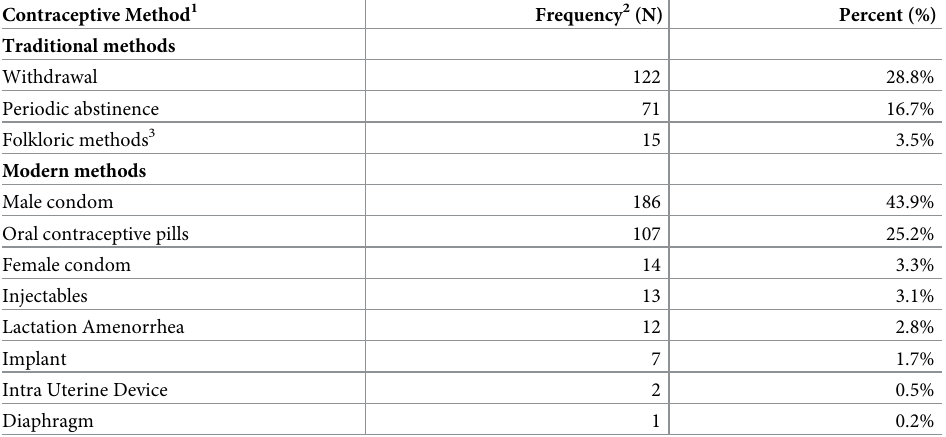
Table 3. Current contraceptive methods used by sexually active female university students (N =